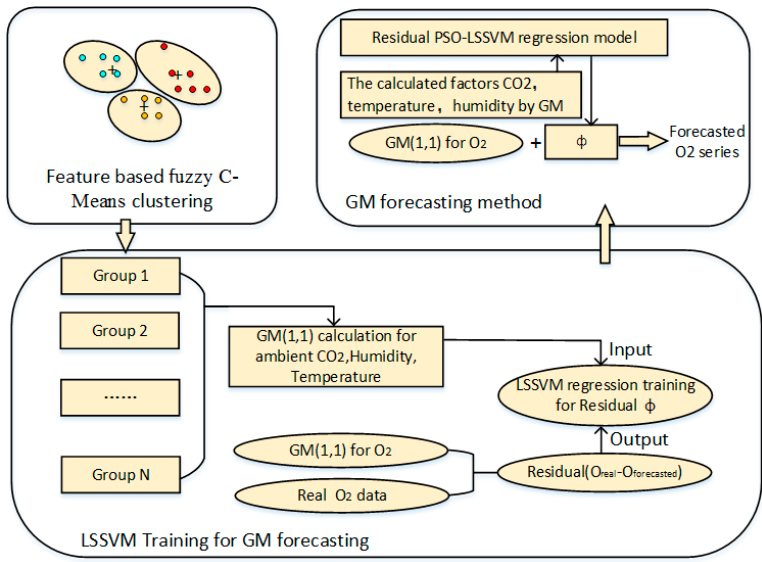
Figure 3. Oxygen concentration forecasting model of flatfish during waterless transportation. PSO: particle swarm optimization; LSSVM: least squares support vector machines; GM: gray model.